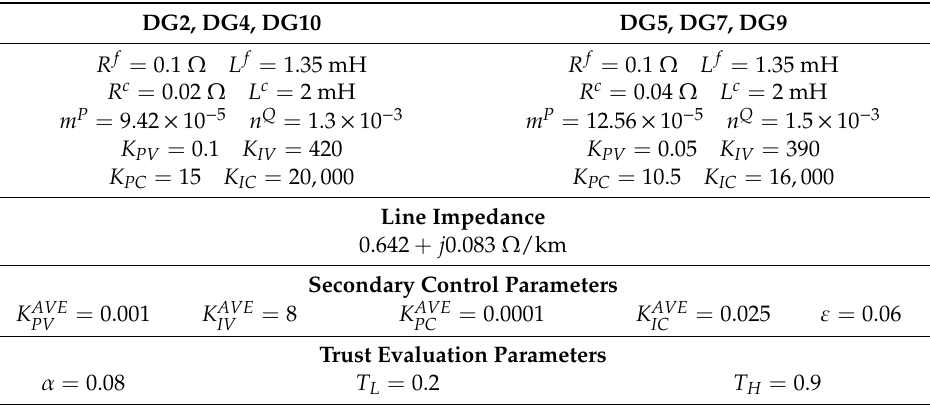
Table A1. Parameter values for